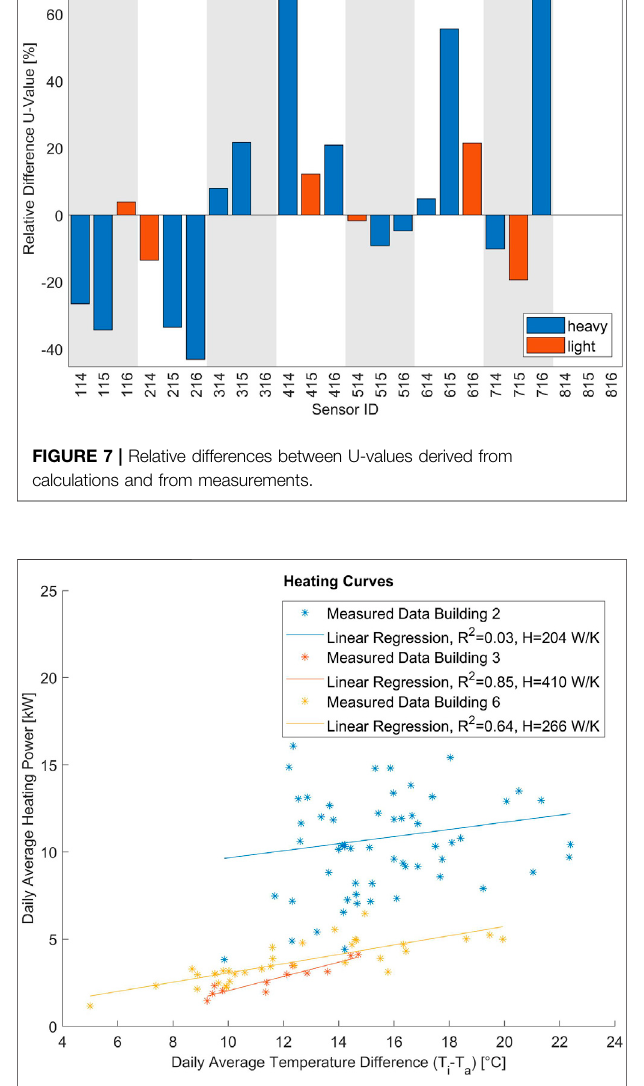
FIGURE 8 | Heating curves of case study buildings, two, three, and